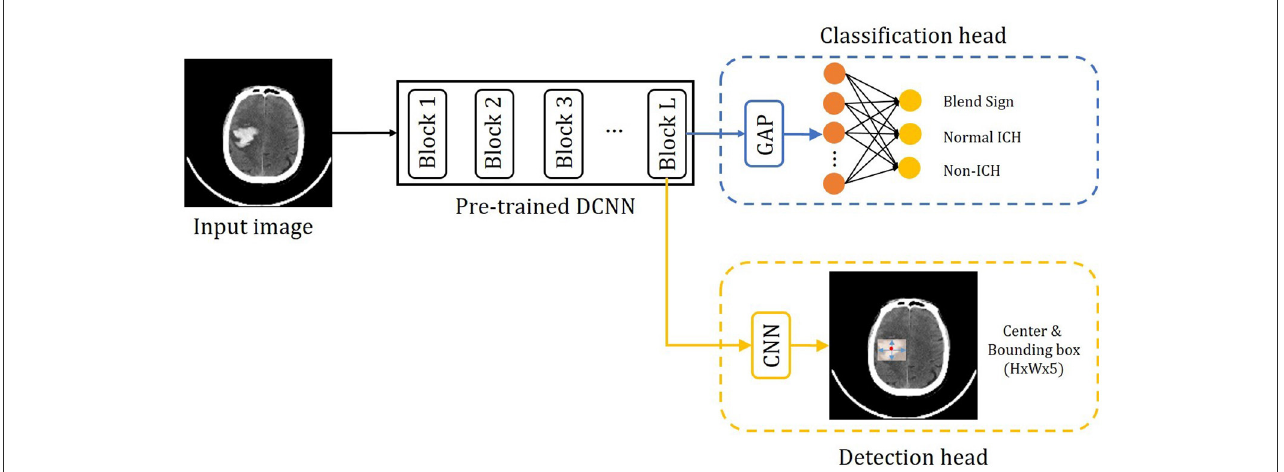
FIGURE4 Overview of the precise diagnosis of the blend sign system. Given one CT slice, we first use a pre-trained CNN (trained on the ImageNet dataset) to extract feature maps, then put the feature maps into the classification branch and the segmentation branch,